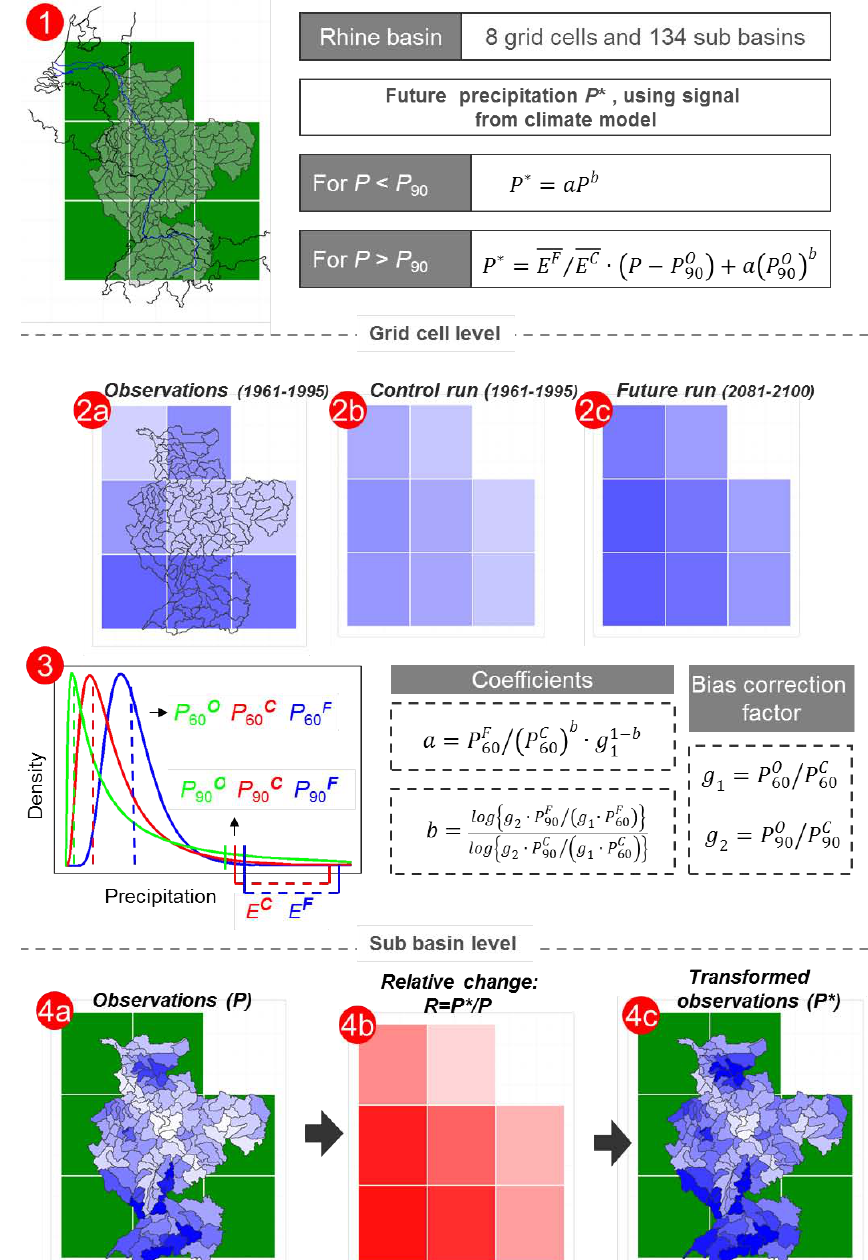
Fig. 1. Overview of the methodology. Panel 1 shows the Rhine basin, divided in 8 (GCM) grid cells and 134 sub-basins. Panel 2 shows the mean precipitation over a 5-day period in each grid cell for the observations and the control and future GCM simulation, all on grid cell level. The observations were upscaled to grid cell level by taking a weighted average over the sub-basins. In panel 3, the probability density of 5-day precipitation is shown, with the 60% ( P 60 ) and the 90% ( P 90 ) quantiles (for the observations as well as for GCM control and future simulations). Also the excess (the amount of precipitation > the 90% quantile) is shown for the control and the future model run. Panel 4 displays the transformation. The daily observations in each sub-basin were multiplied by the change factor R , which was obtained from the observed ( P ) and transformed ( P ∗ ) 5-day precipitation amount and depends on the coefficients a and b and for P >P 90 also on E F / E C . For each sub-basin the daily precipitation was transformed using the GCM signal from the grid cell that contains most of its surface